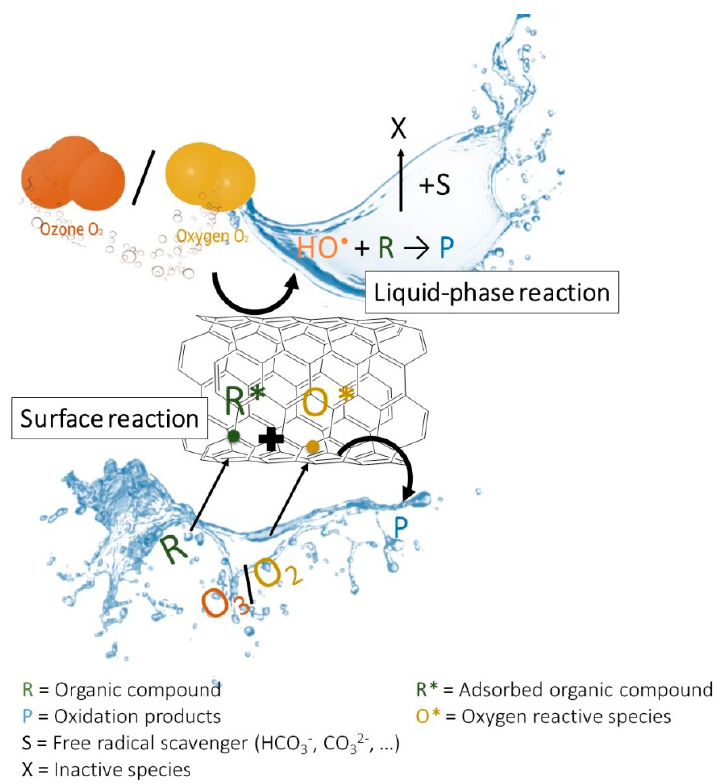
Figure 10. Scheme of the reactions that might occur between the surface of CNTs and the oxidative